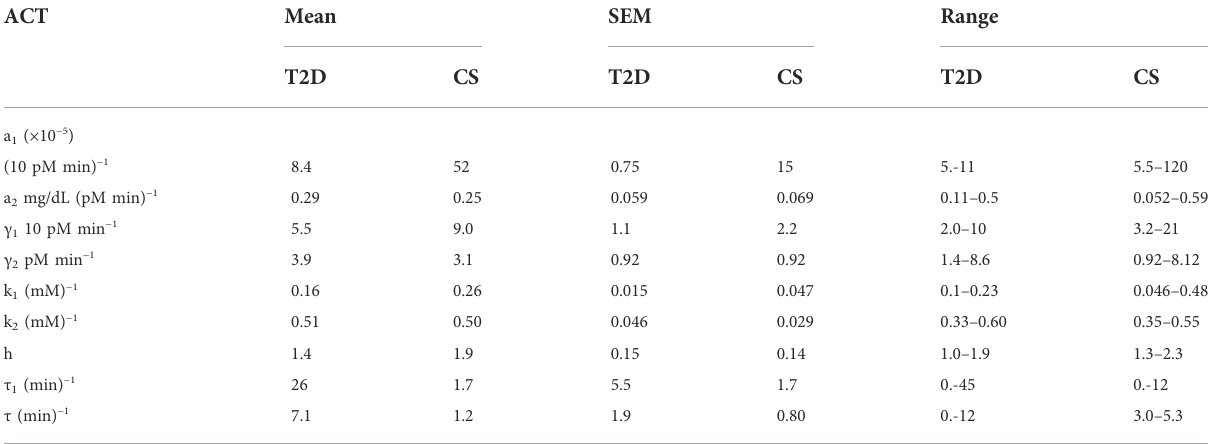
TABLE 3 Average values, standard errors, and ranges of the parameters in patients with T2D and CS